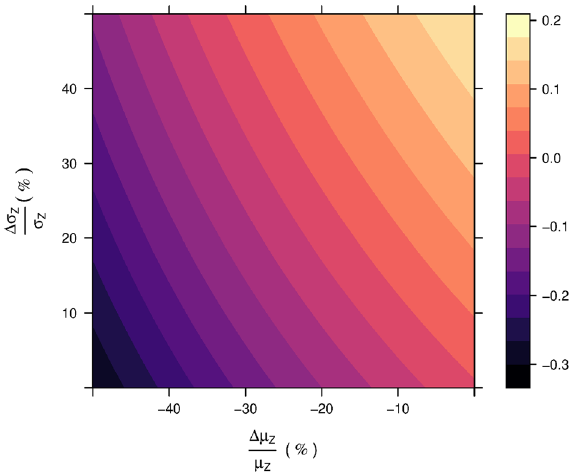
Figure 3. Relative change in rx COV under the paired vs. unpaired assumptions. Plot of (cid:31) rx COV as a function of relative deviation in mean and standard deviation resulting from differences due to the paired and unpaired assumption. The deviation in relative mean value ranges from 0% through 50%, while that in standard deviation ranges from − 50% through 0%. The colorbar indicates the corresponding deviation in (cid:31) rx COV